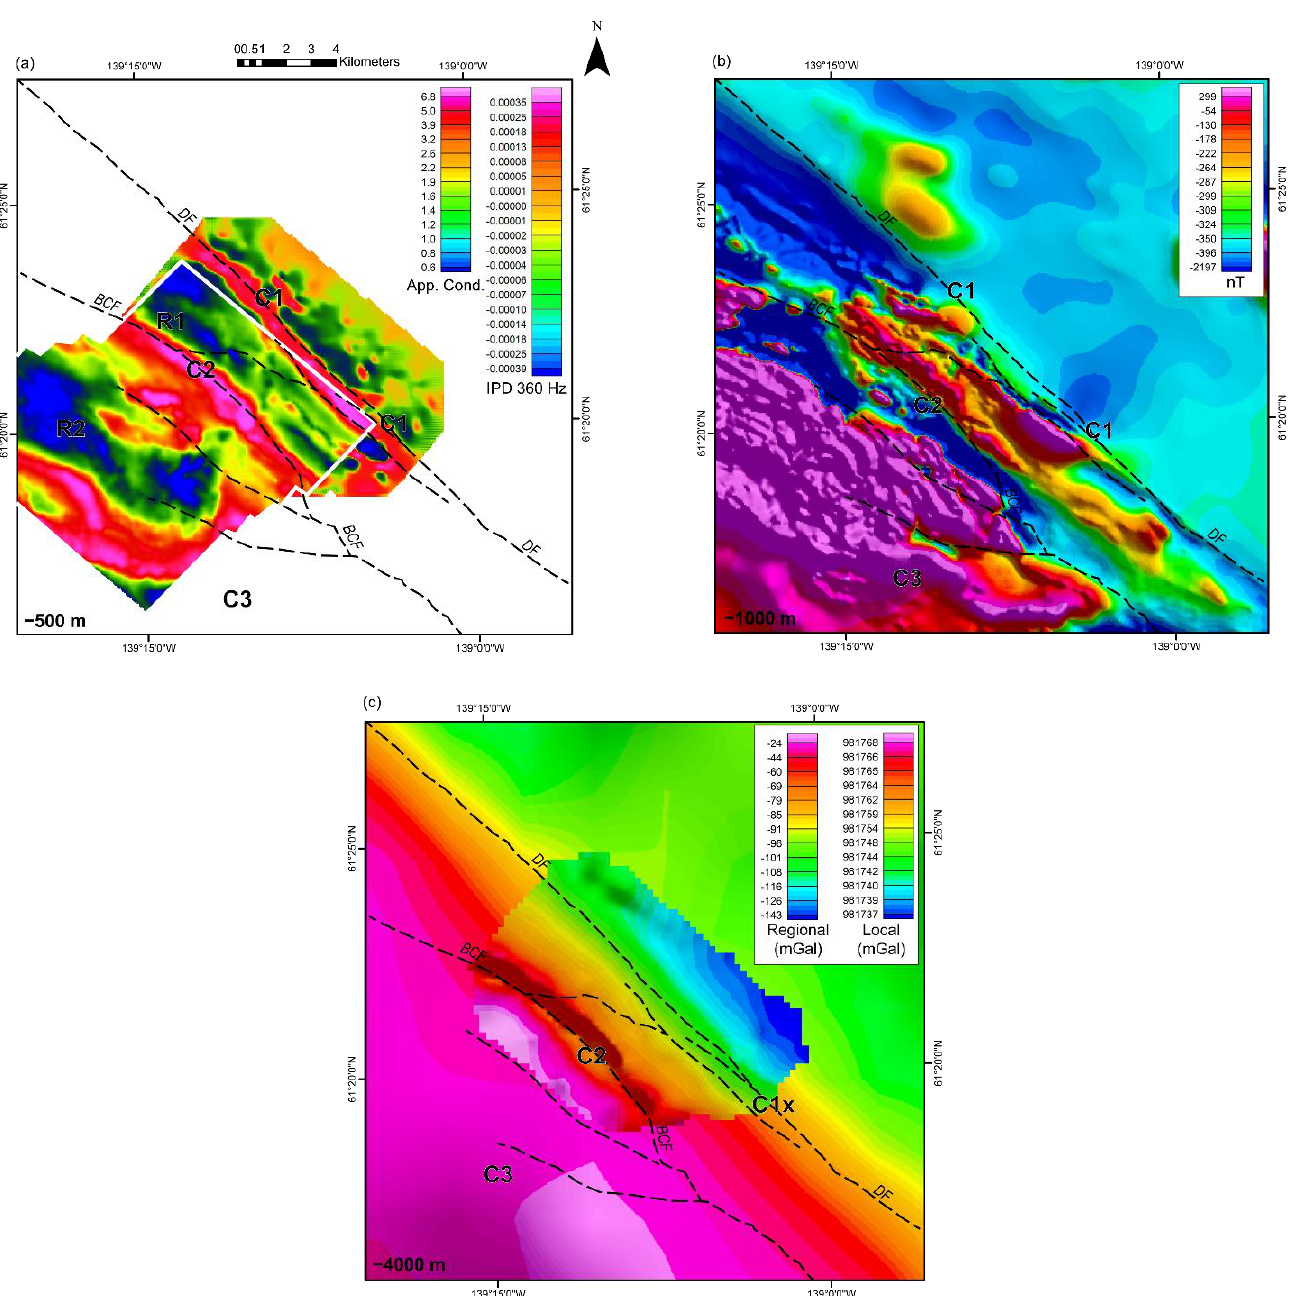
Figure 7. ( a ) Apparent conductivity, channel 6, grid from airborne EM data [25] (outlined in white) displayed over 360 Hz ELF-EM in-phase divergence grid [3] with labels from 5b plotted; ( b ) Residual total field with labels from 5c plotted; and ( c ) Ground Bouguer gravity data (Local) from [3] over regional Bouguer gravity data (Regional) with labels from 5e plotted. Faults in the study area plotted as black dashed lines. Details on the acquisition and processing of ground gravity data are found in [3], apparent conductivity data in [25] and ELF-EM in-phase divergence data in [3].